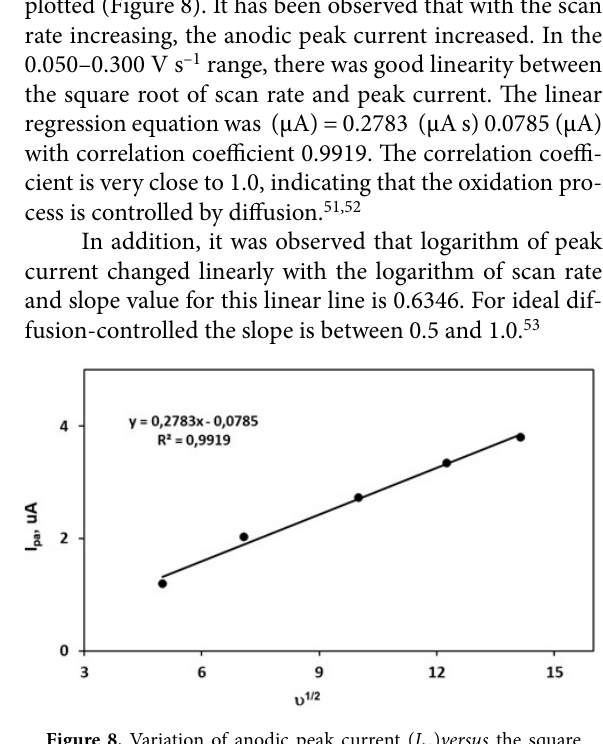
Figure 8. Variation of anodic peak current ( I p a ) versus the square root of scan rate ( υ 1/2